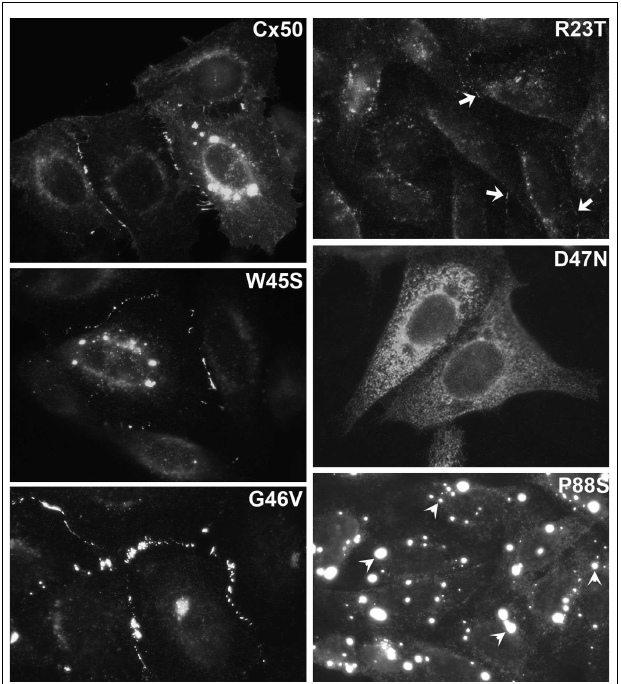
FIGURE 4 | Immunofluorescent localization of wild type Cx50 and of different cataract-associated Cx50 mutants (R23T,W45S, D47N, G46V, and P88S) after their expression by transfection of HeLa cells. Similar to wild type Cx50,W45S and G46V show abundant localization in a punctate distribution along appositional membranes corresponding to gap junction plaques.The abundance of plaques is very reduced for R23T, but small spots at appositional membranes are occasionally observed. D47N and P88S show no localization consistent with gap junction plaque formation. D47N is found in a reticular, cytoplasmic distribution. P88S localizes in intensely fluorescent cytoplasmic inclusions. Reproduced and adapted from Berthoud et al. (2003), Arora et al. (2008),Thomas et al. (2008), and Tong et al. (2011).